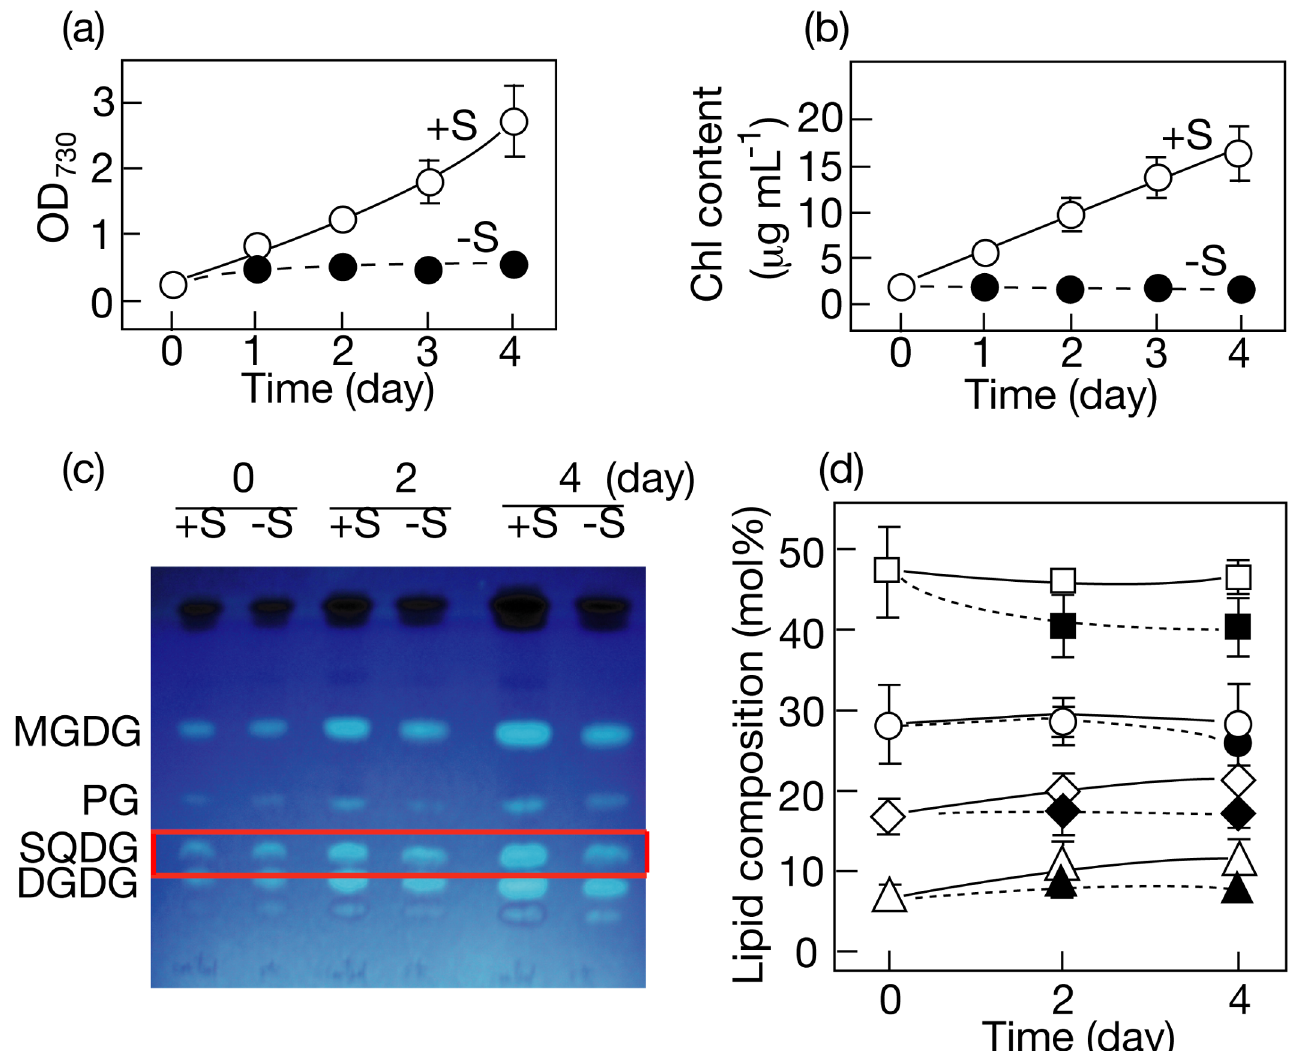
Fig 3. Effects of S-starvation on cell growth, and Chl and polar lipid contents in Synechocystis . OD 730 (a) and the Chl a content (b) were determined for a culture of cells under +S (open circles) or–S (closedcircles) conditions. (c) The changesin TLC profiles of polar lipids are shown for a culture of cells under +S or–S conditions. The solvent system used for development of total cellularlipids was CH 3 Cl/CH 3 OH/conc. NH 3 solution (130:70:10by vol.). (d) Changesin the polar lipid compositionsare shown for cells grown under +S (open symbols) or–S (closedsymbols) conditions. MGDG, squares. DGDG, diamonds.SQDG, circles. PG, triangles. The values shown are the averages ± SD for three distinct groups of data.